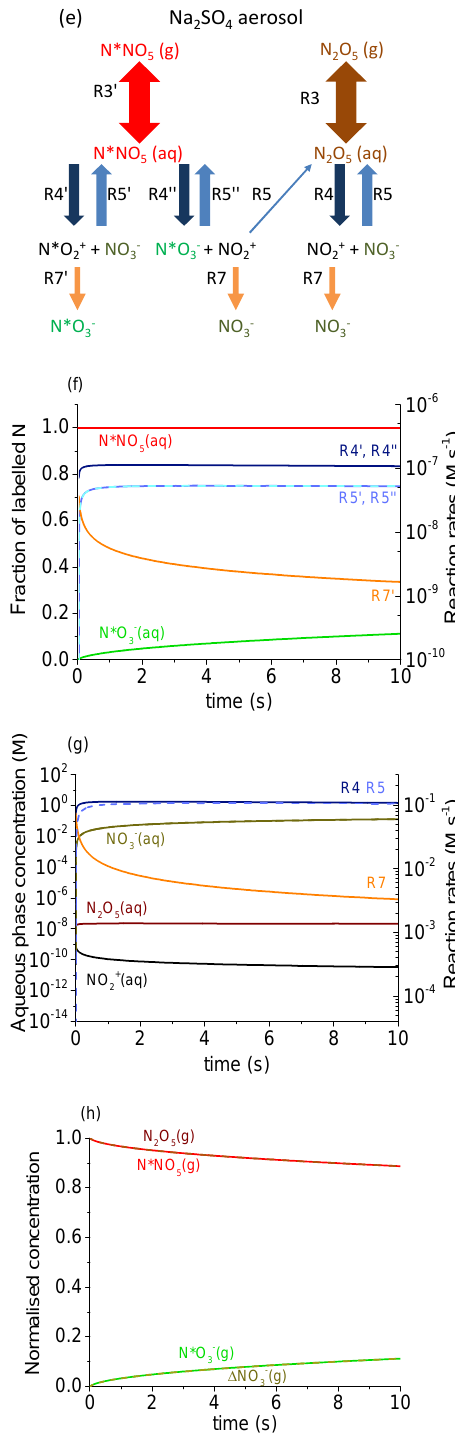
Figure 3. (a) The chemical mechanism of N 2 O 5 hydrolysis and chemical isotope exchange in nitrate-containing solutions. N ∗ refers to 13 N. (b, c, d) Results of box model calculations for NaNO 3 aerosol at 70% RH: evolution as a function of time of (b) the fraction of labelled N 2 O 5 in the aqueous phase (red, left axis) and ratio of labelled nitrate to the total number of labelled N 2 O 5 initially available (green, left axis); rates of reactions relevant for the budget of aqueous phase 13 N (light to dark blue, right axis); (c) rates of reactions relevant for the budget of non-labelled species in the aqueous phase; (d) evolution of normalized gas-phase N 2 O 5 (labelled, red; non-labelled, brown) and aqueous-phase nitrate (labelled, green; non-labelled, olive) as a function of time. (e, f, g, h) Scheme and plots of the same quantities but for Na 2 SO 4 aerosol at 70% RH in the absence of pre-existing